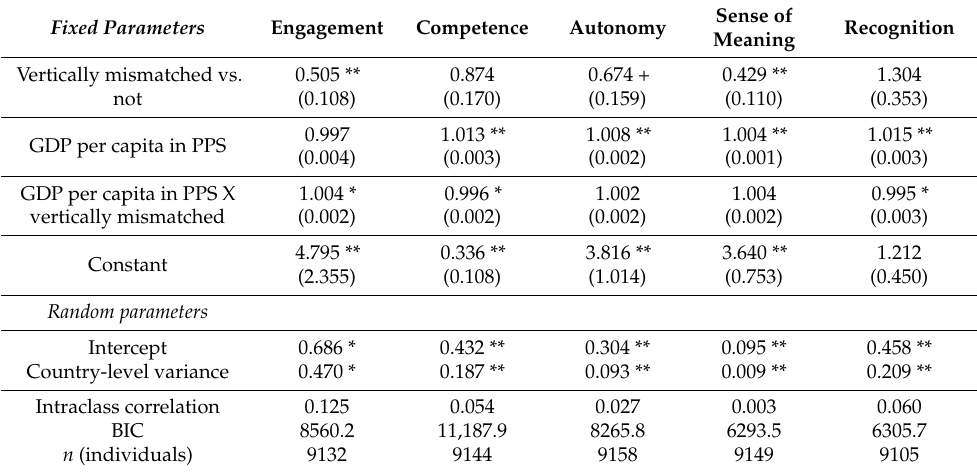
Table 3. Influence of vertical mismatch on different aspects of subjective well-being and cross-level interactions between vertical mismatch and GDP per capita in PPS, odds ratios (standard errors in parentheses).